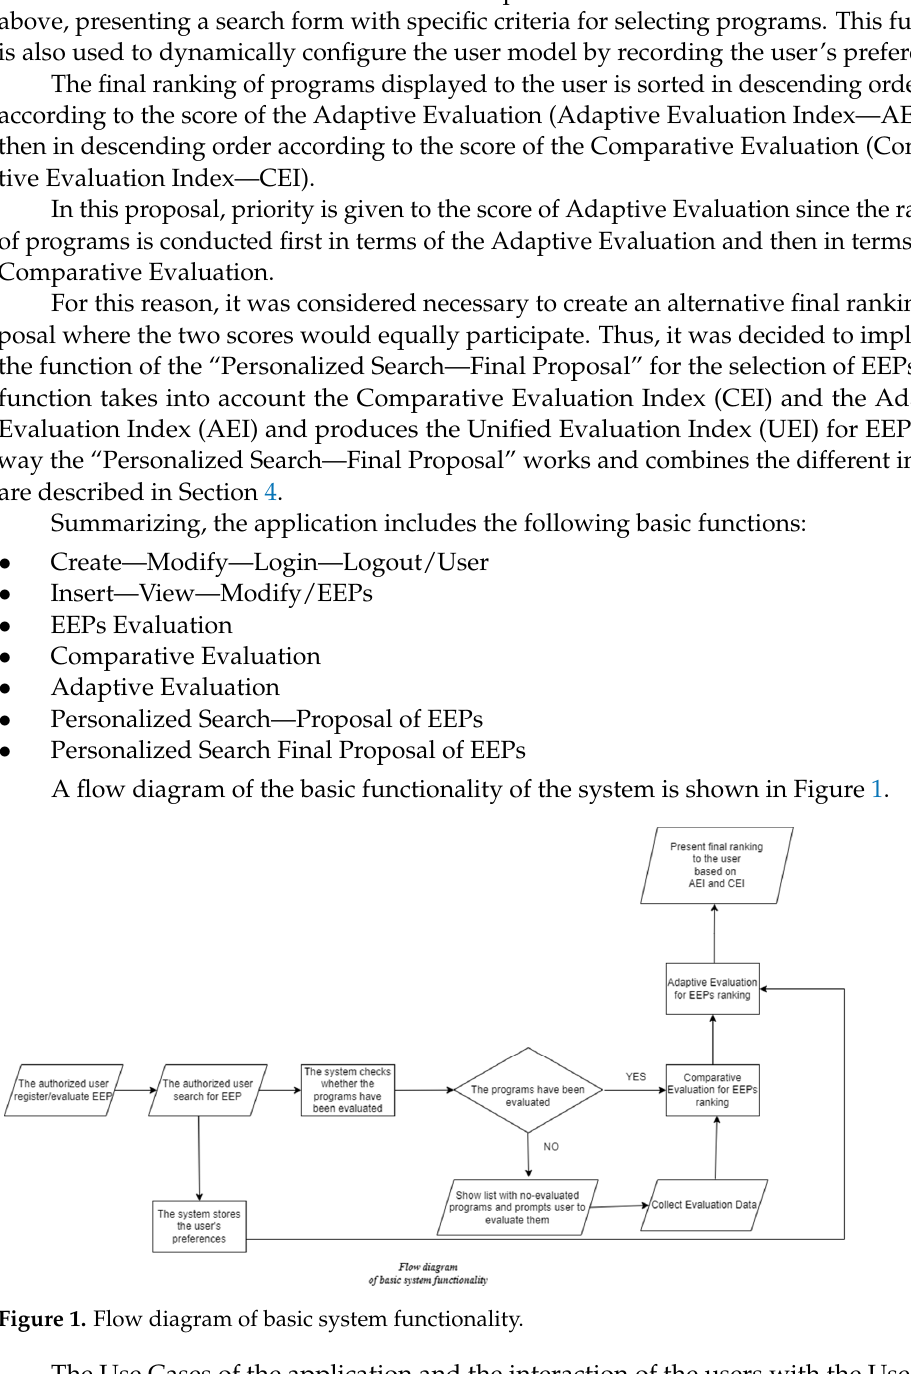
Figure 2 . Use Case Diagram .